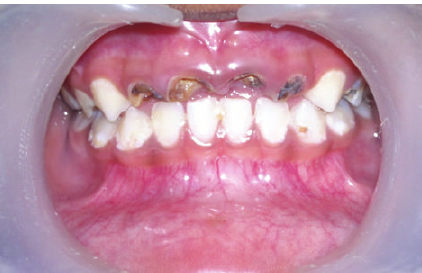
Figure 1: Preoperative clinical picture showing grossly decayed teeth 51, 52, 61, and 62.